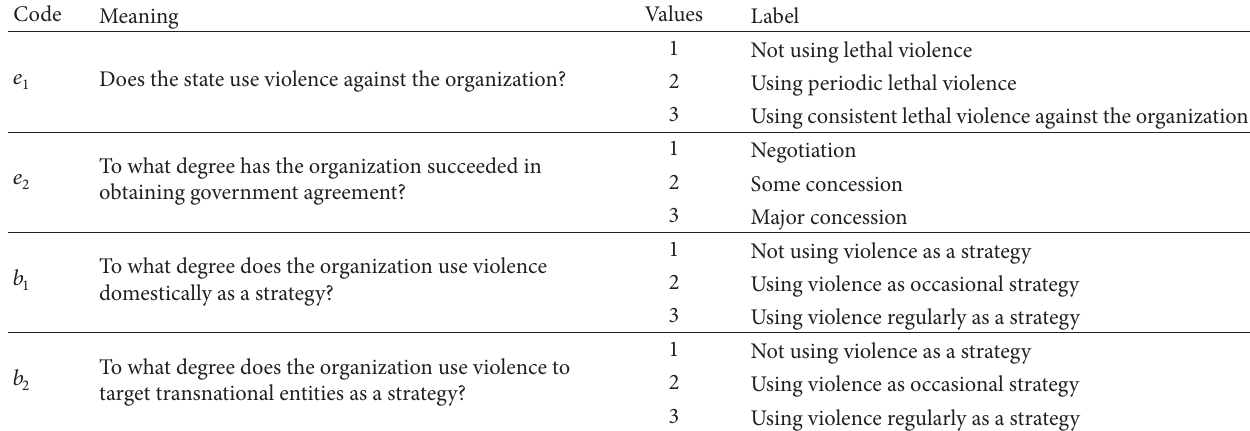
Table 3: Attributes and